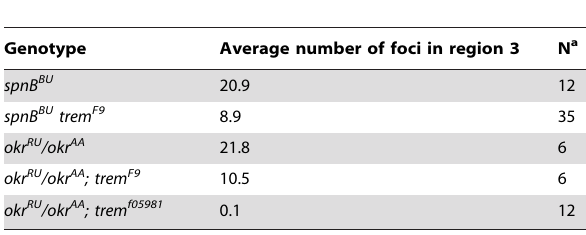
Table 5. Double strand break formation as measured by c - His2Av staining in DNA repair mutants.